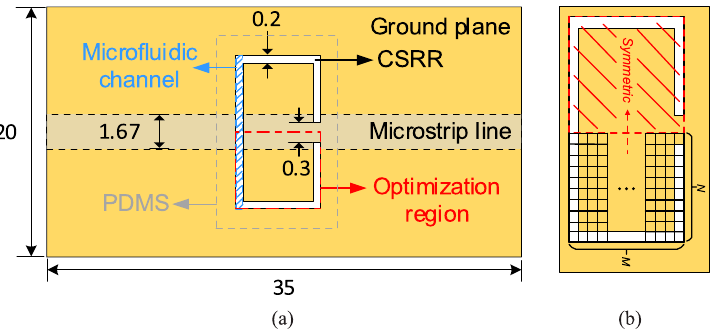
Figure 25. Design flow of the CSRR pixelation: ( a ) initial design of the microfluidic sensor based on a classical CSRR (all the dimensions are in mm); ( b ) pixelated CSRR structure. Reprinted with permission from Ref.